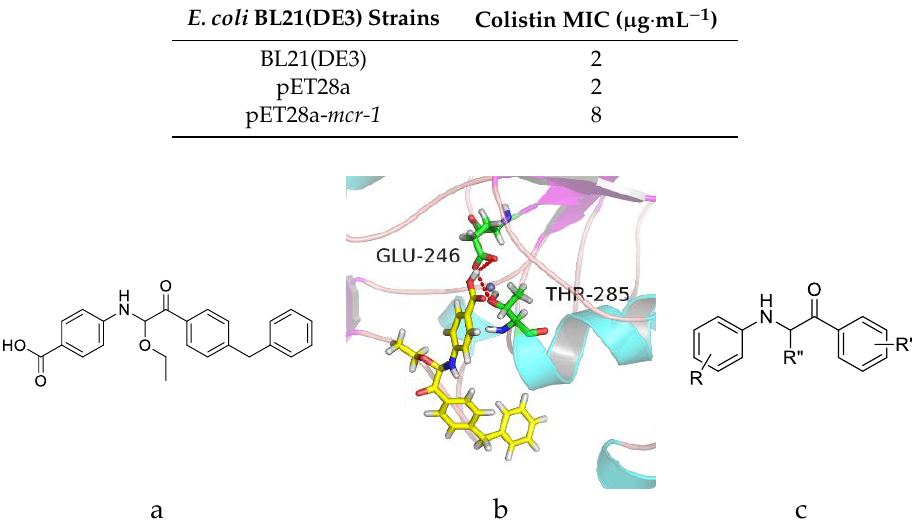
Figure 2. ( a ) Structure of racemic compound 3 . ( b ) Docking pattern of the interactions between compound 3 and MCR-1 catalytic domain with H-bonds shown by red lines. ( c ) The core structure of 1-phenyl-2-(phenylamino) ethanone.